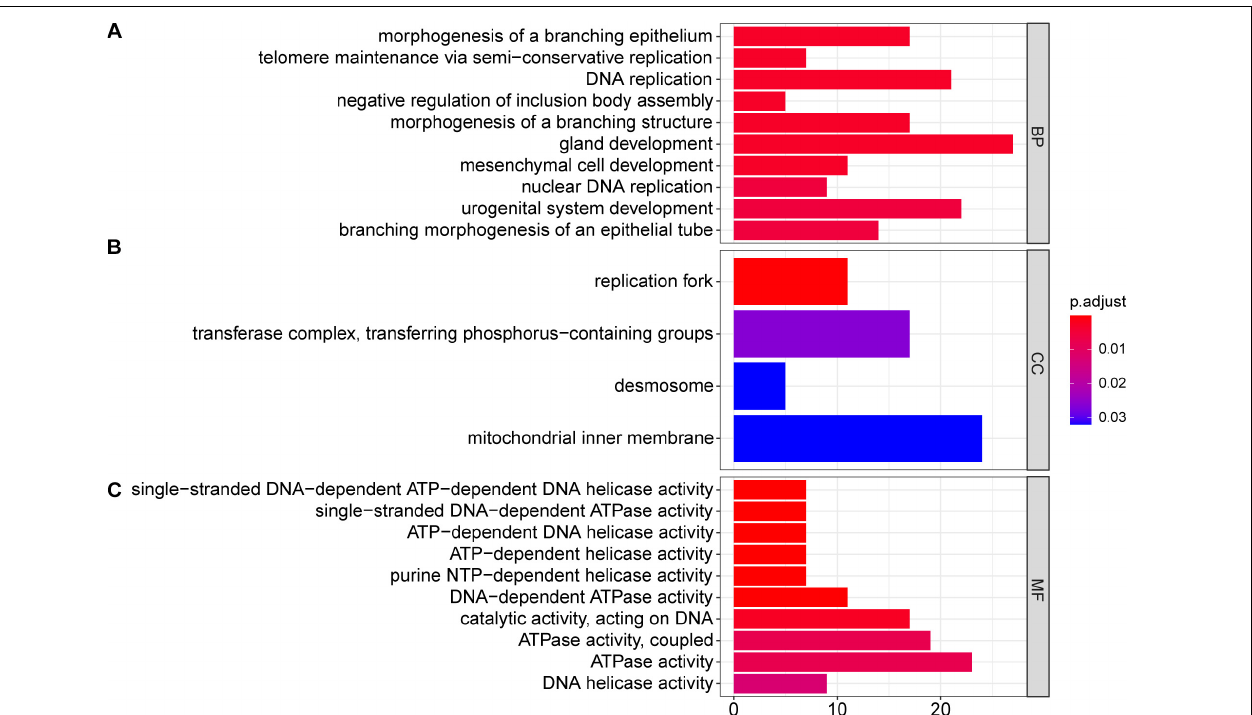
FIGURE 2 | GO analysis of 504 differentially expressed mRNAs in TC–EC interaction, in which gland development, DNA replication, urogenital system development, morphogenesis of a branching epithelium, morphogenesis of a branching structure, branching morphogenesis of an epithelial tube, mesenchymal cell development, nuclear DNA replication, telomere maintenance via semi-conservative replication, and negative regulation of inclusion body assemble are the top 10 biological process (A) ; mitochondrial inner membrane, transferase complex (transferring phosphorus-containing groups), replication fork, and desmosome are main cell components (B) ; ATPase activity, catalytic activity acting on DNA, DNA-dependent ATPase activity, and helicase activity are the enriched molecular functions (C) . P < 0.05 was considered as statistically significant.